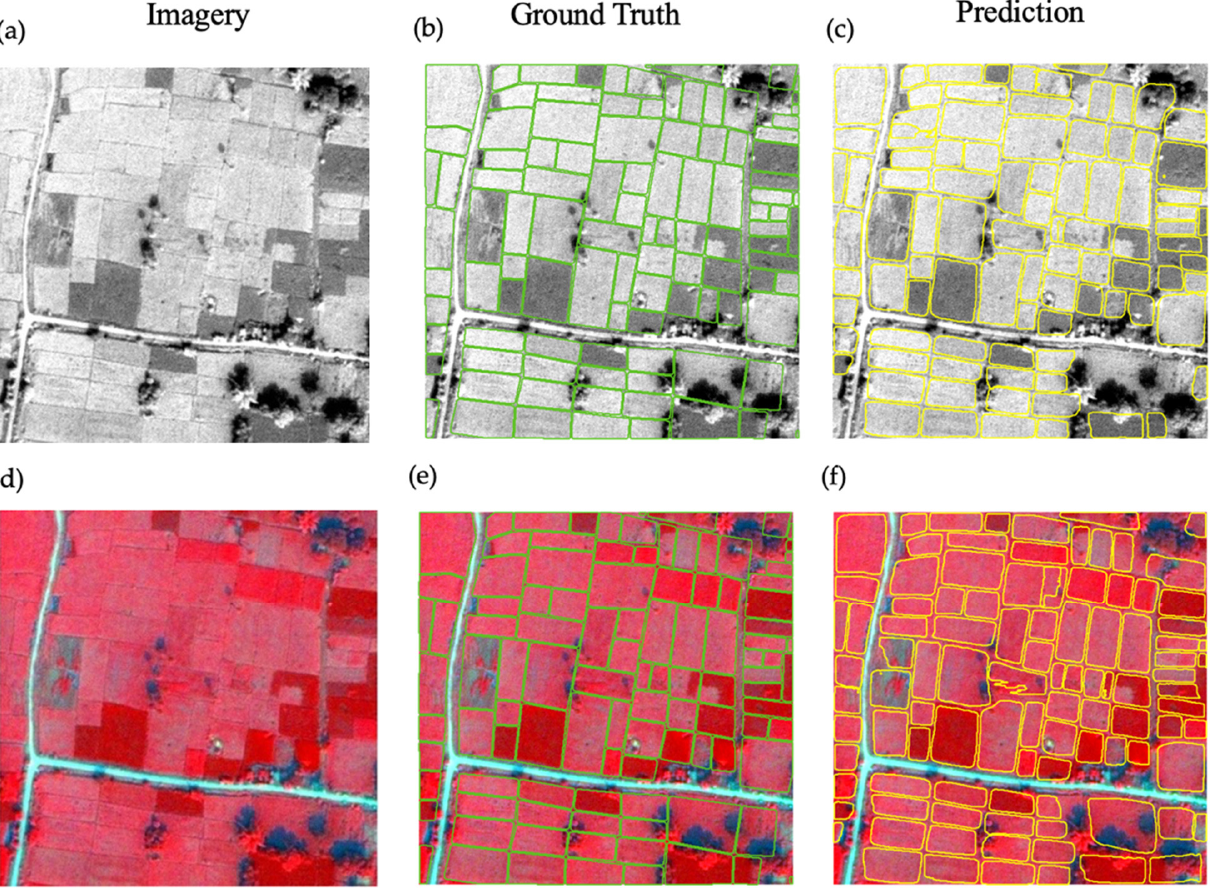
Figure 5. One example of a 512 × 512 pixels WV-3 unenhanced tile in Bihar. Panel ( a ) shows the original panchromatic image, ( b ) shows the panchromatic image with ground truth, ( c ) shows the panchromatic image with delineated field boundaries, ( d ) shows the original multispectral image, ( e ) shows the multispectral image with ground truth, and ( f ) shows the multispectral image with delineated field boundaries. Results are shown for the final model, which included the iteratively collected data. Green lines represent ground truth boundaries and yellow lines represent predicted boundaries.